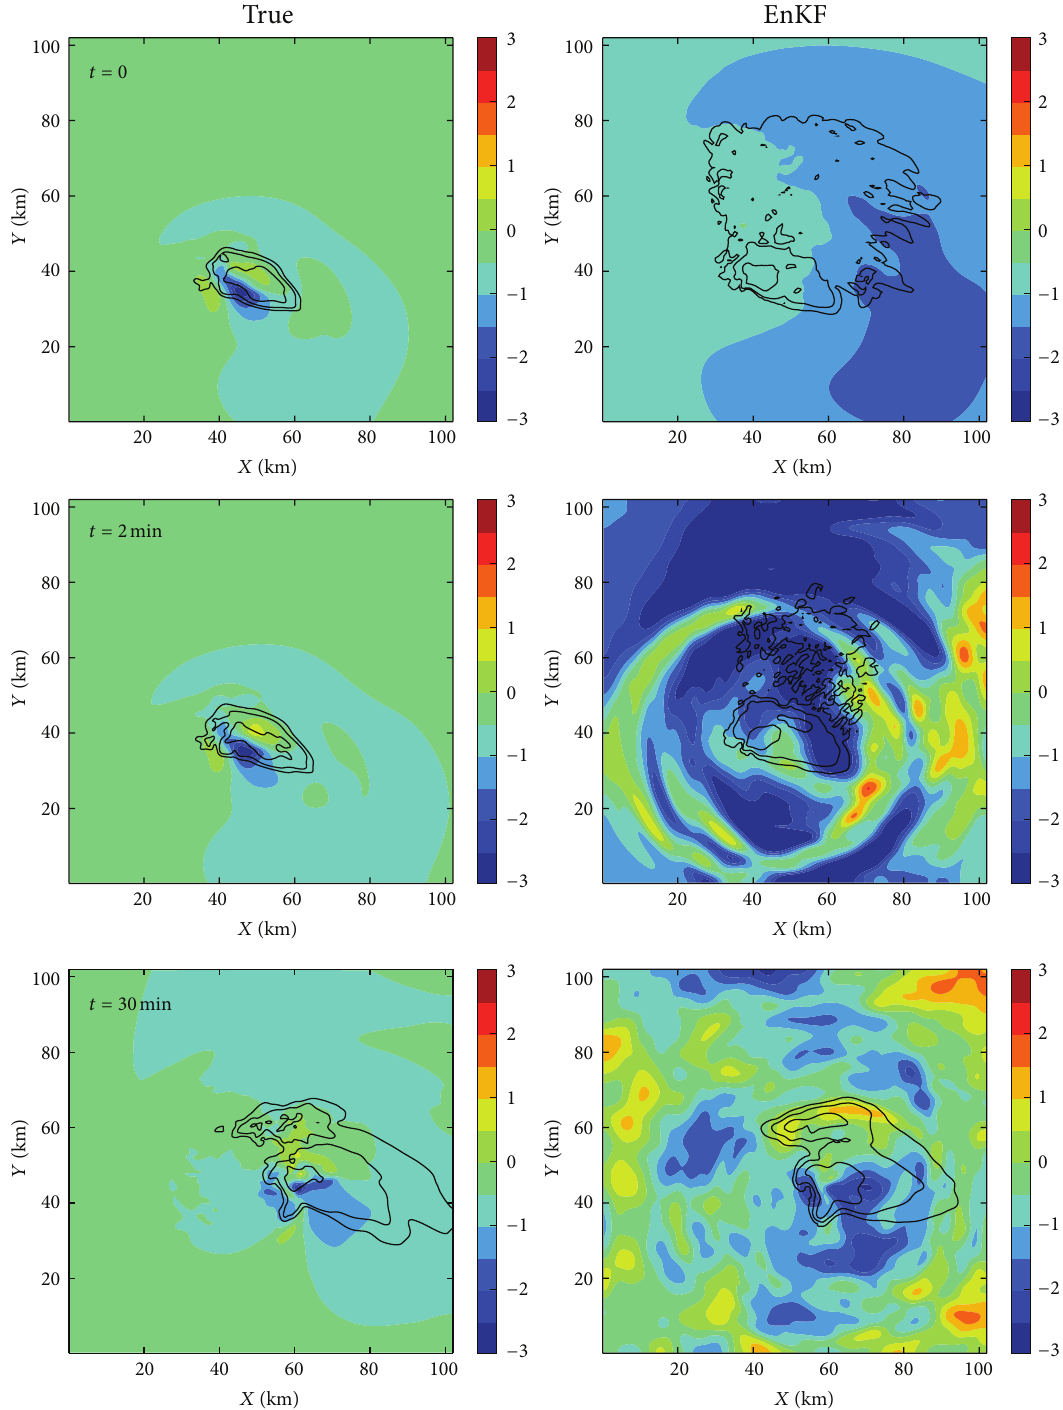
Figure 1: True (left column) and EnKF mean posterior (right column) 𝑝 󸀠 (shading; hPa) and radar reflectivity factor (contoured at 10, 30, and 50 dBZ) at 𝑧 = 0.9 km. Fields are valid after (top row) zero, (middle row) one, and (bottom row) fifteen 2min forecast cycles. The true 𝑝 󸀠 were filtered and averaged as in Potvin et al. [23] to permit more direct comparisons with the (coarser) EnKF 𝑝 󸀠